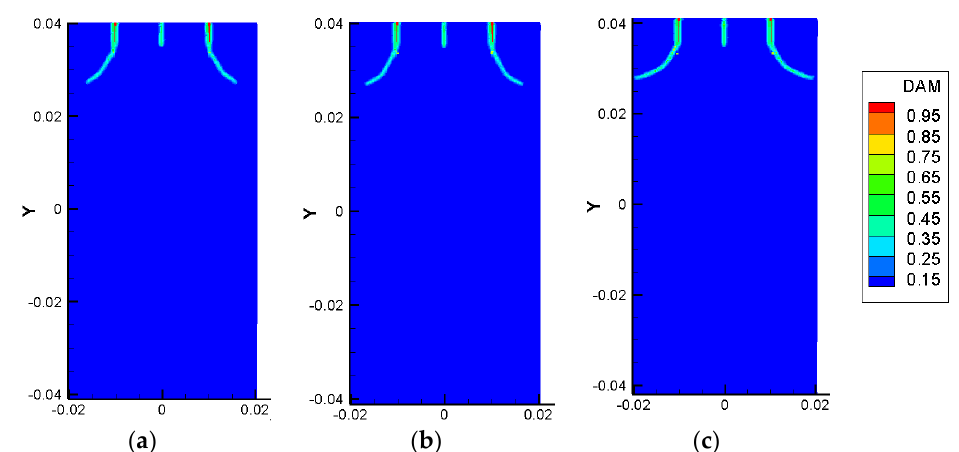
Figure 16. Propagation and deflection of cracks in FGM coatings with different coating thickness: ( a ) 8 mm; ( b ) 10 mm; ( c ) 12 mm.